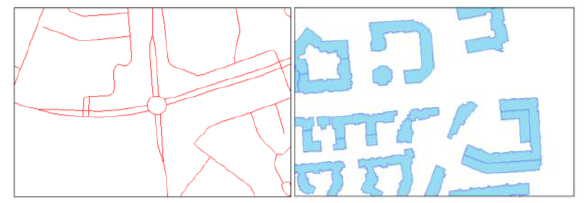
Figure 5. Models of grey infrastructure features in TD: lines (e.g. roads) and polygons (e.g. buildings).